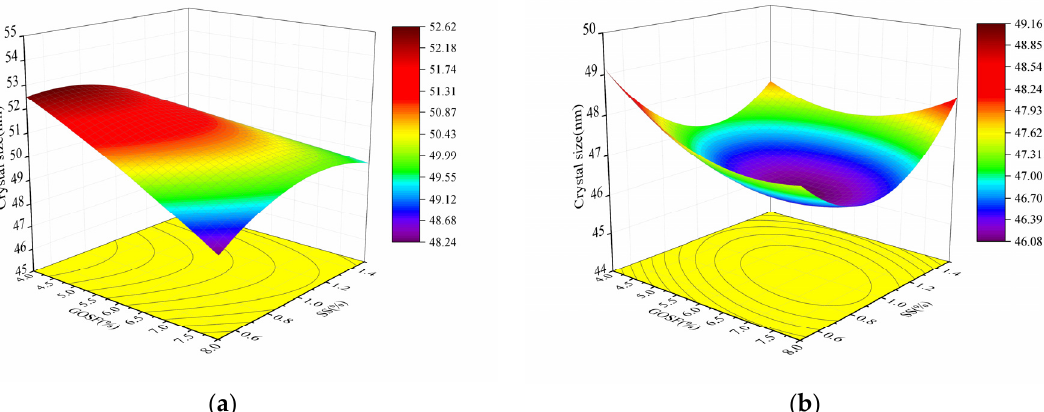
Figure 17. CH crystal size of samples at 3 days ( a ) and 28 days ( b ) vs. the dosages of GOSF and SS.